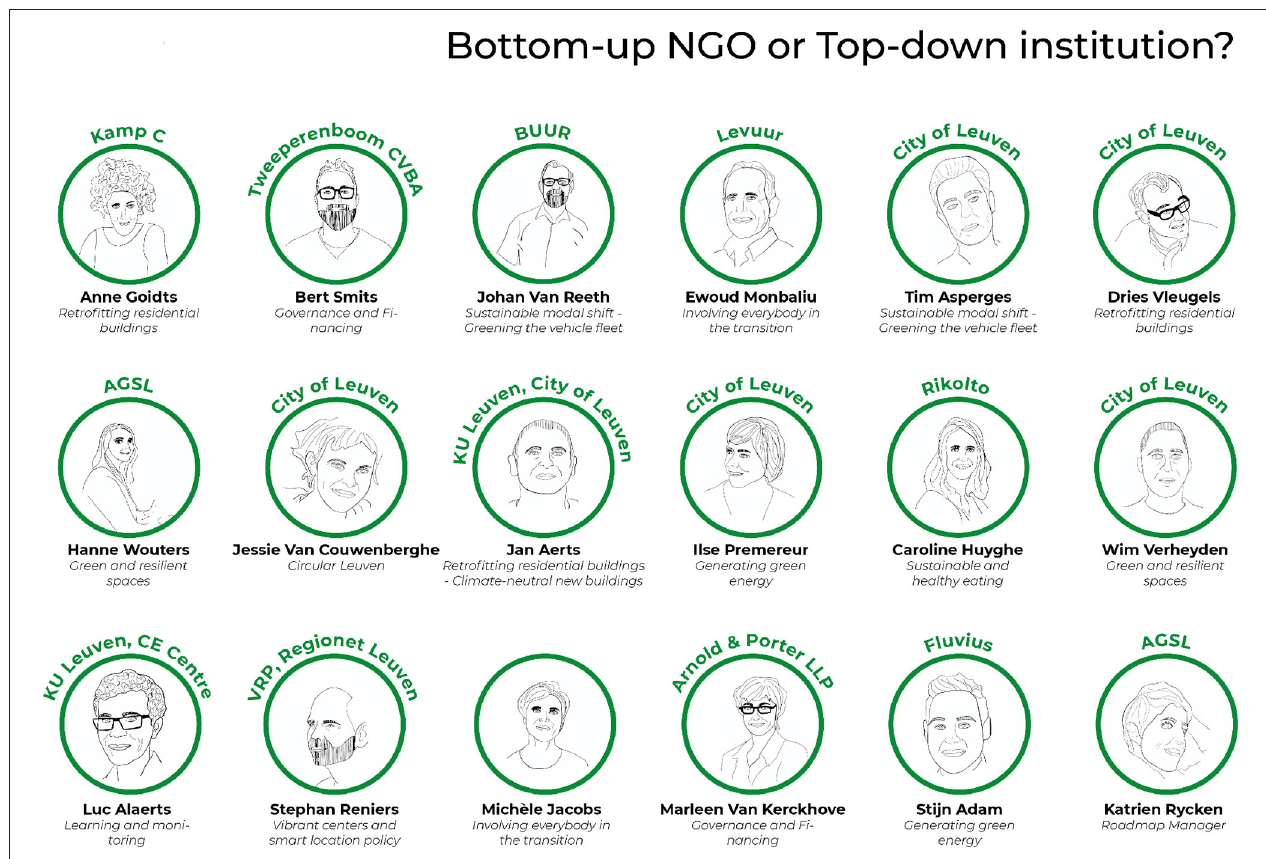
FIGURE 8 | List of Programme facilitators in Leuven2030 and the company they work for as depicted in the Leuven Gymkhana posters. (Source: authors’ elaboration from Leuven2030 website).